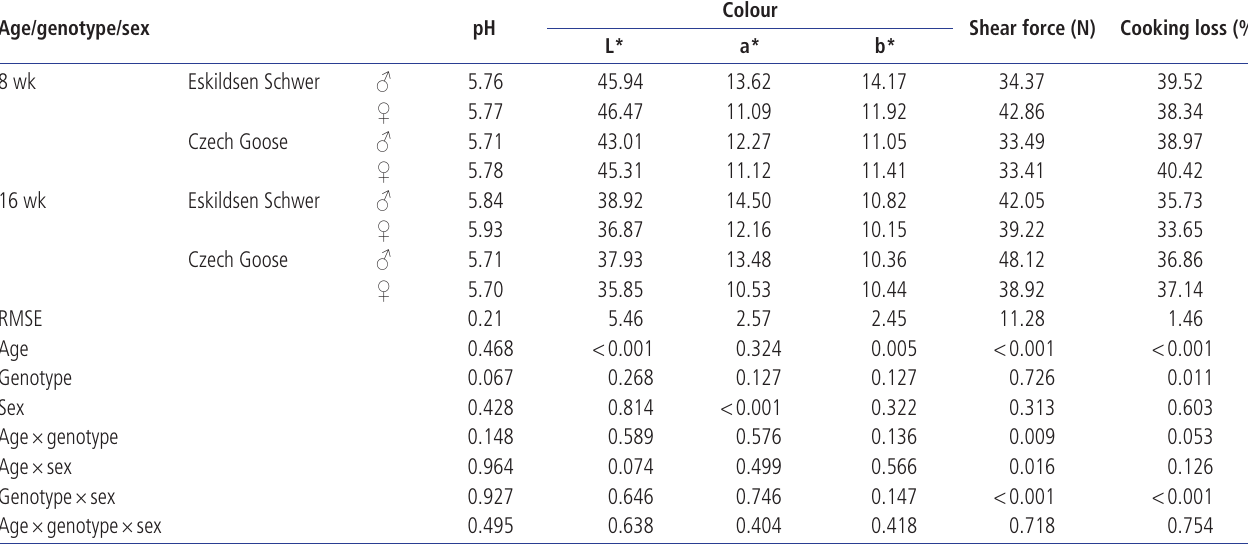
Table 3. pH value, colour parameters, shear force and cooking loss of musculus pectoralis major measured 24 h after slaughtering in geese as affected by age, genotype, and sex